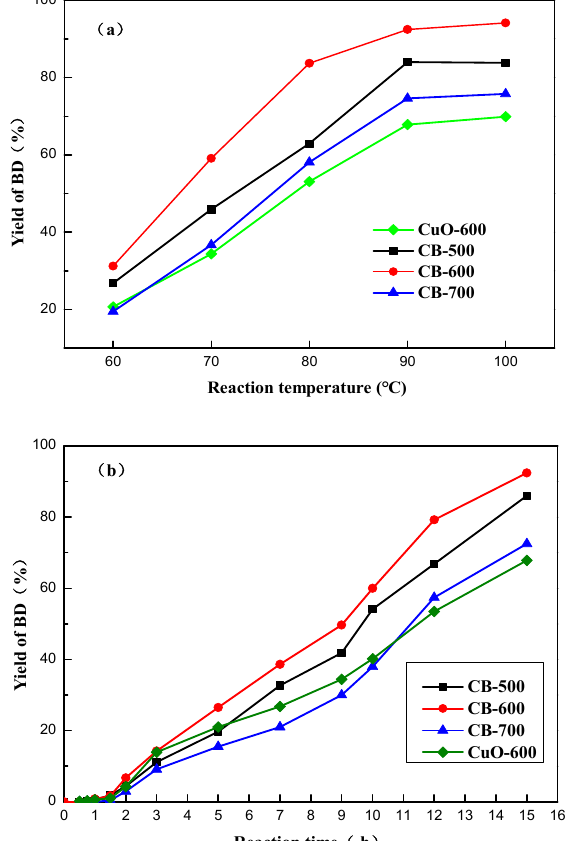
Figure 9. Yields of 1,4-butynediol (BD) over various CuO-Bi 2 O 3 and CuO catalysts as functions of temperature ( a ) and time ( b ).